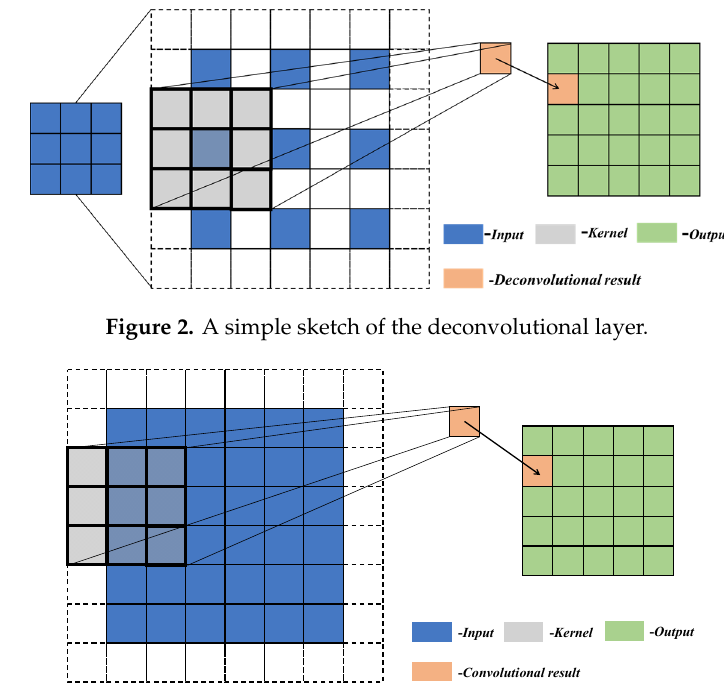
Figure 3. A simple sketch of the convolutional layer.